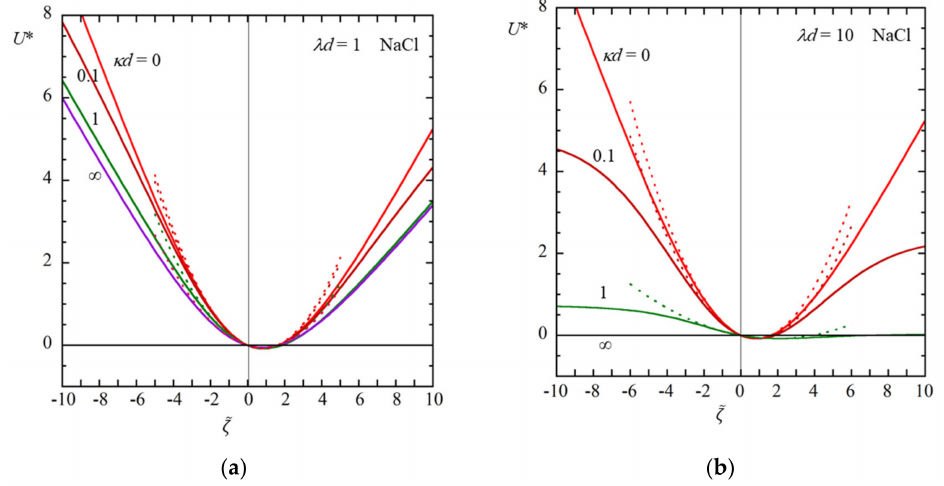
Figure 4. Scaled diffusiophoretic mobility U * of a large soft particle as a function of the scaled zeta potential (cid:101) ζ for several values of κ d at λ d = 1 ( a ) and λ d = 10 ( b ) in an aqueous NaCl solution ( β = − 0.2). Solid lines are results obtained with Equation (61). Results obtained with a low potential approximation with Equation (66) are also given as dotted